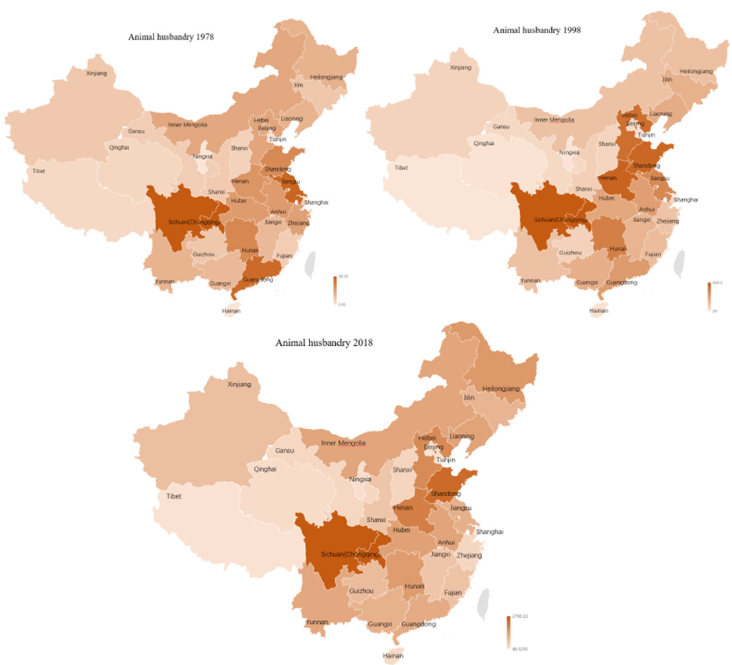
Figure 18. Geographic distribution of animal husbandry GDP in 1978–2018.